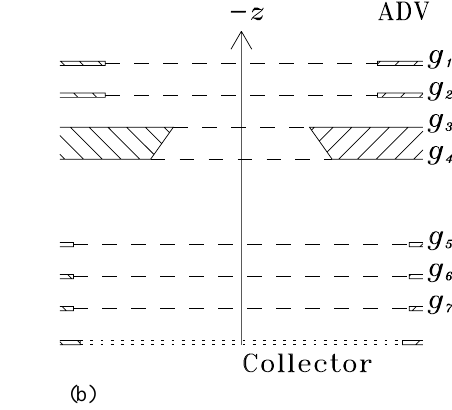
Fig. 1. Sketches of the APR and ADV analysers. Collectors are shown by dotted lines, grids by slashed lines and the grounded structures by shaded surfaces. Axis z is aligned with satellite